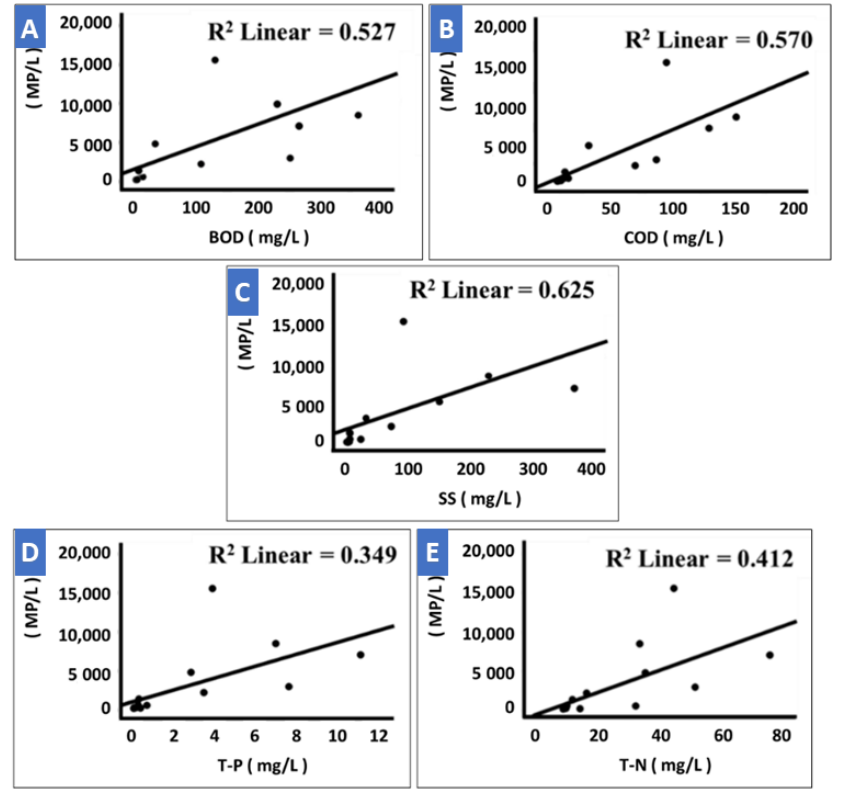
Figure 6. Correlation of microplastic concentrations with five wastewater quality parameters. 3.4. Microplastic pollutant load. ( A ) Microplastic concentration relationship with biological organic demand (BOD); ( B ) Microplastic concentration relationship with chemical oxygen demand (COD); ( C ) Microplastic concentration relationship with suspended solids (SS); ( D ) Microplastic concentration relationship with total phosphorus (T-P); ( E ) Microplastic concentration relationship with total nitrogen (T-N).